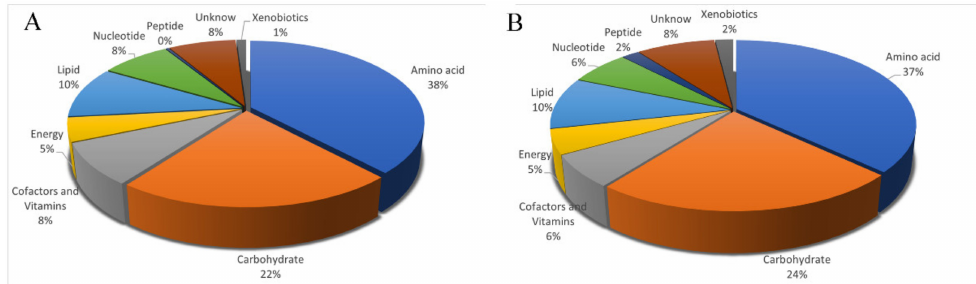
Figure 3. Pie chart of the relative content of various annotated metabolites in the uropygial gland of floor-reared ducks and cage-reared ducks. ( A ). The relative content of various annotated metabolites in the uropygial gland of floor-reared ducks. ( B ). The relative content of various annotated metabolites in the uropygial gland of cage-reared